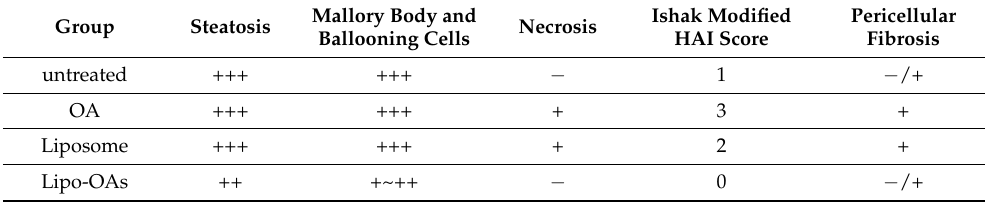
Mallory Body and Ballooning Cells